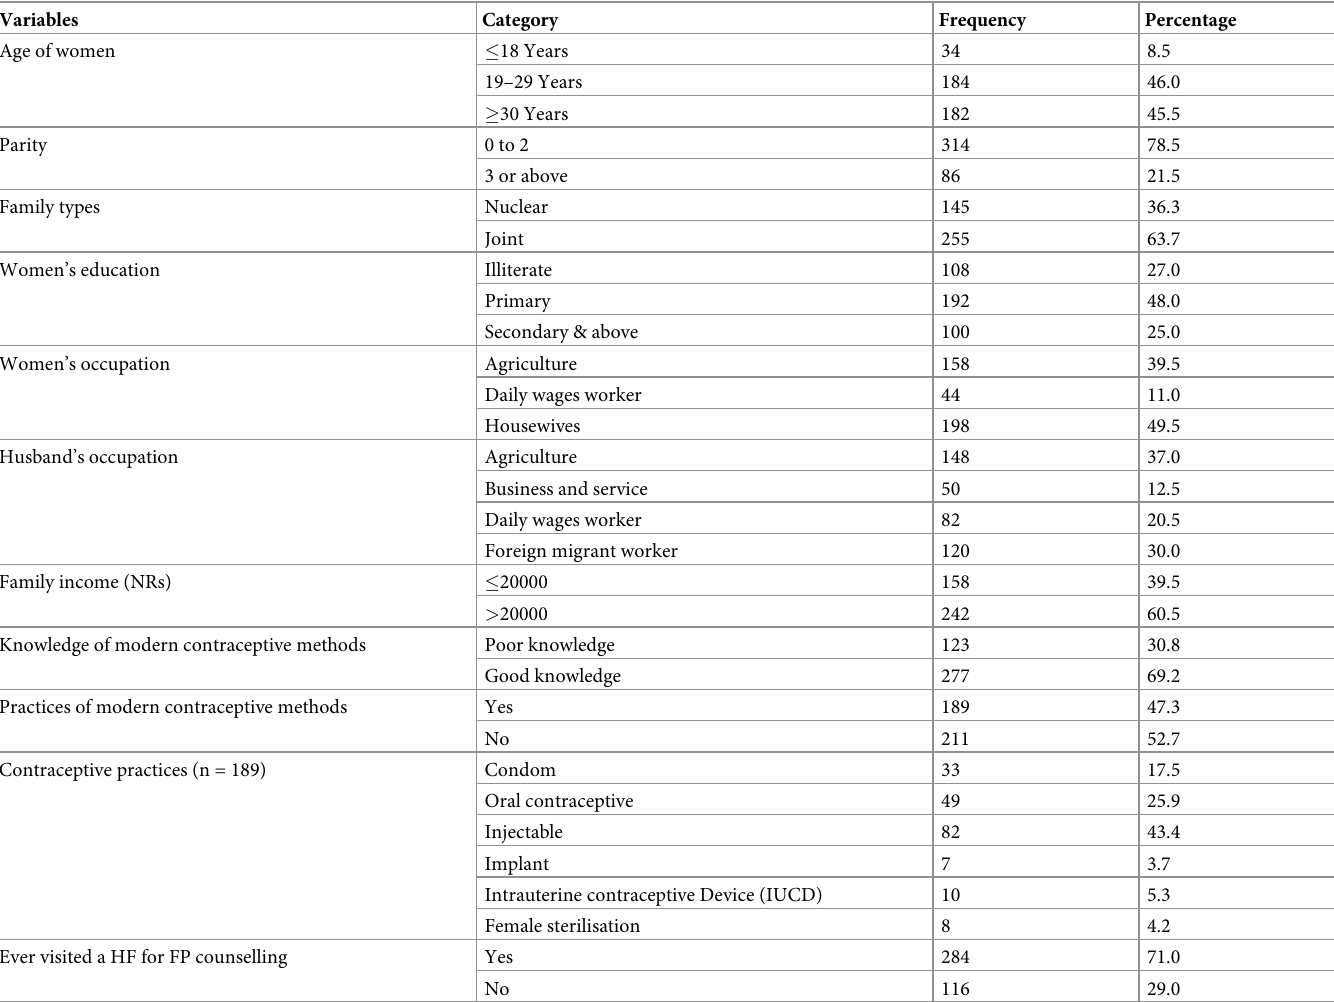
Table 1. Background characteristics and modern contraceptive methods, knowledge, and practices of Muslim women (N = 400) in